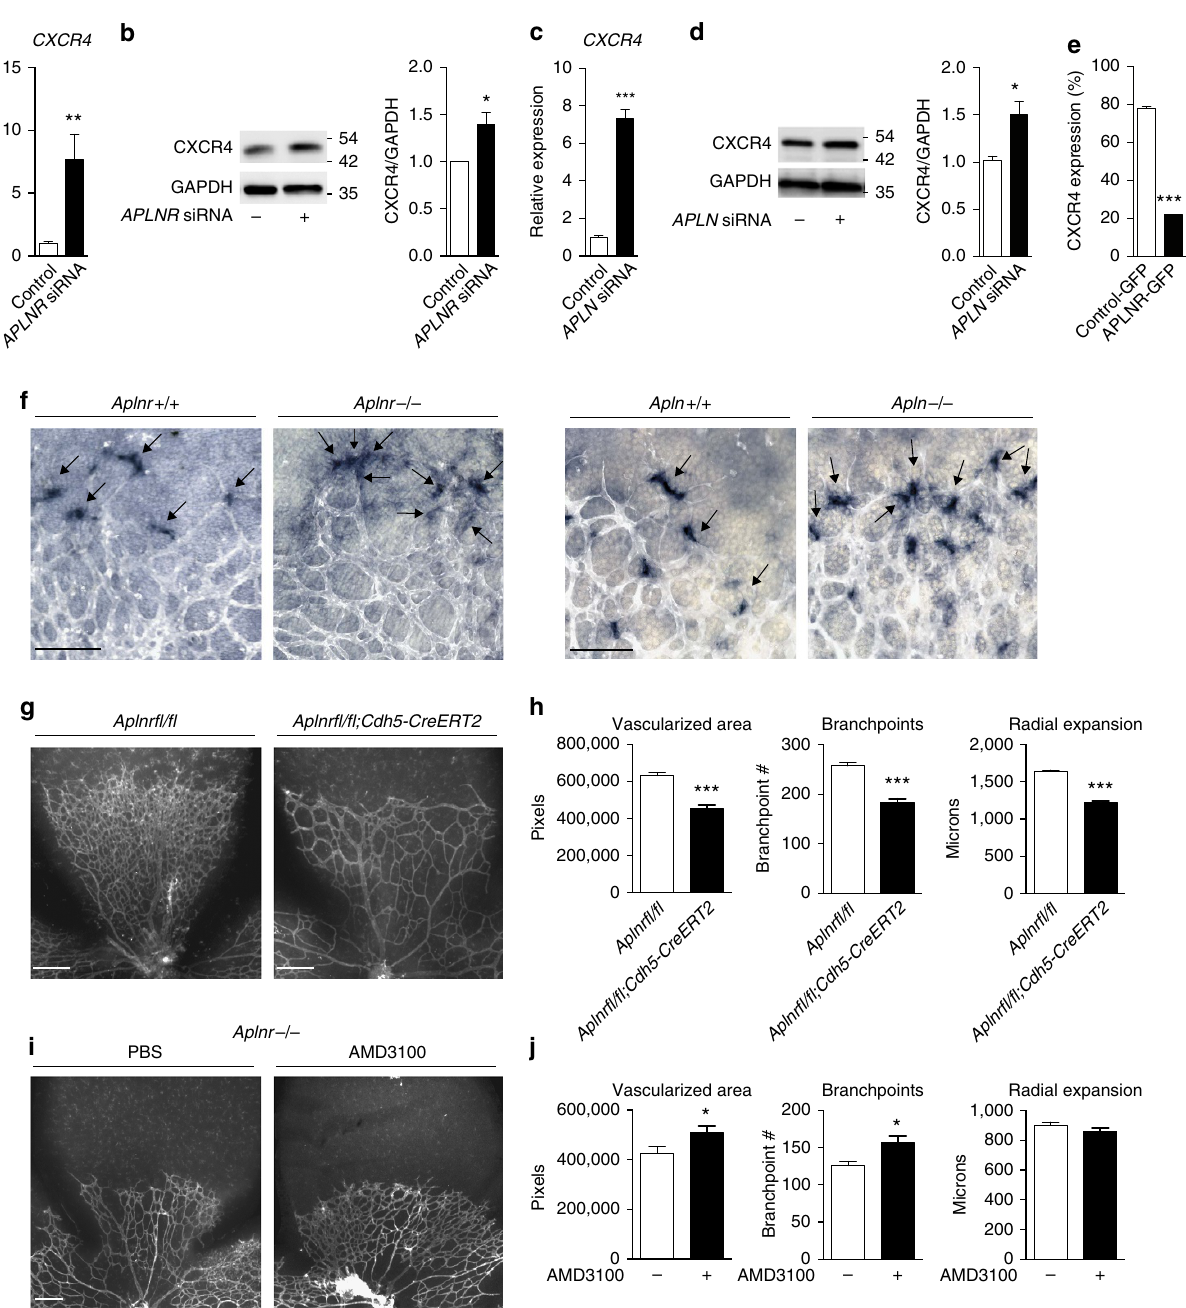
Figure 1 | Apelin/APLNR regulates CXCR4 expression in vitro and in vivo . ( a – d ) CXCR4 transcript and protein levels in response to siRNA-mediated knockdown of APLNR ( a , b ) or APLN ( c , d ). n ¼ 3 experiments per condition. ( e ) Flow cytometry to determine level of CXCR4 expression in HUVECs transfected with either APLNR-GFP or GFP expression constructs. Data shown represents the CXCR4 staining of cells among the GFP-positive cells. n ¼ 3 experiments. ( f ) Cxcr4 expression (blue) in P5 retinal vessels as assessed by in situ hybridization in Aplnr (cid:2) / (cid:2) and Apln (cid:2) / (cid:2) mice. Arrows indicate Cxcr4 mRNA localization. Isolectin B4 is shown in white. Scale bar, 100 m m. n ¼ 8 retinas per genotype. ( g , h ) Retinal vasculature of P5 mice with endothelial-specific deletion of Aplnr ( Aplnrfl/fl;Cdh5-CreERT2 ). Graphs depict vascularized area, branchpoints and radial expansion. Scale bar, 200 m m. n Z 6 retinas per genotype. ( i , j ) Effect of AMD3100 on Aplnr (cid:2) / (cid:2) retinal vasculature. Scale bar, 200 m m. n Z 5 retinas per genotype. * P o 0.05, ** P r 0.01, *** P r 0.001, t -test. Error bars represent s.e.m.